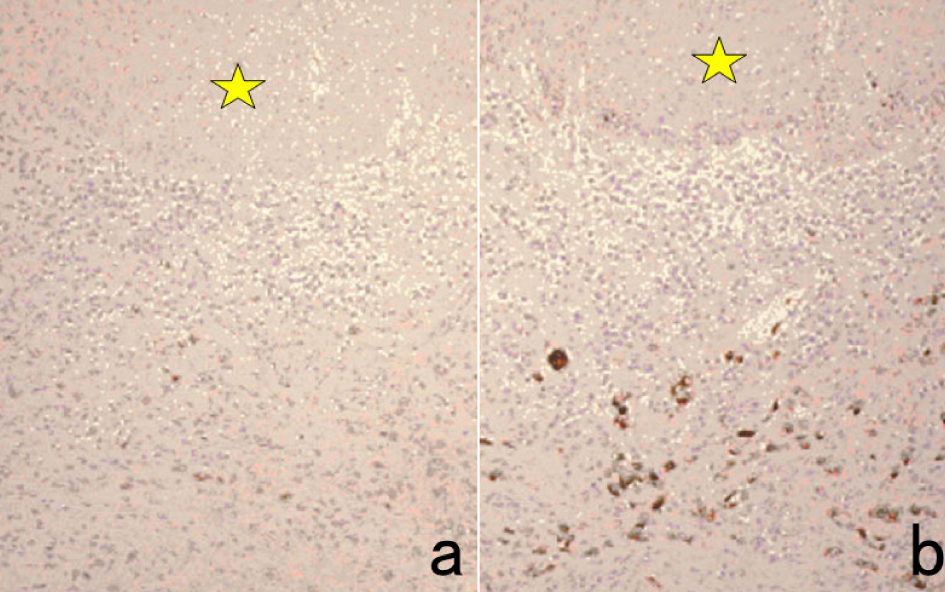
Figure 2. p53 immunostaining without HIER in esophageal squamous cell carcinoma. ( a ): Polymer method (EnVision) and ( b ): catalyzed signal amplification (CSA)-II method. Submucosally invading cancer cells express p53 in the nuclei. The immunoreactivity is significantly enhanced by the CSA-II method using FITC tyramide as an amplifier. Stars indicate non-cancerous esophageal squamous